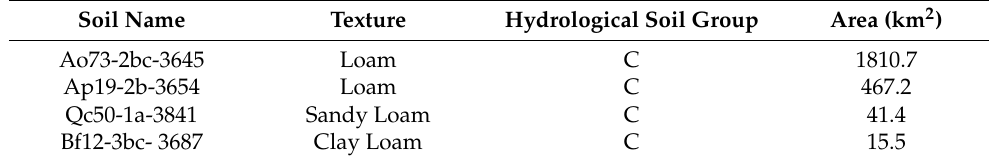
Table 1. Soil classification and description.